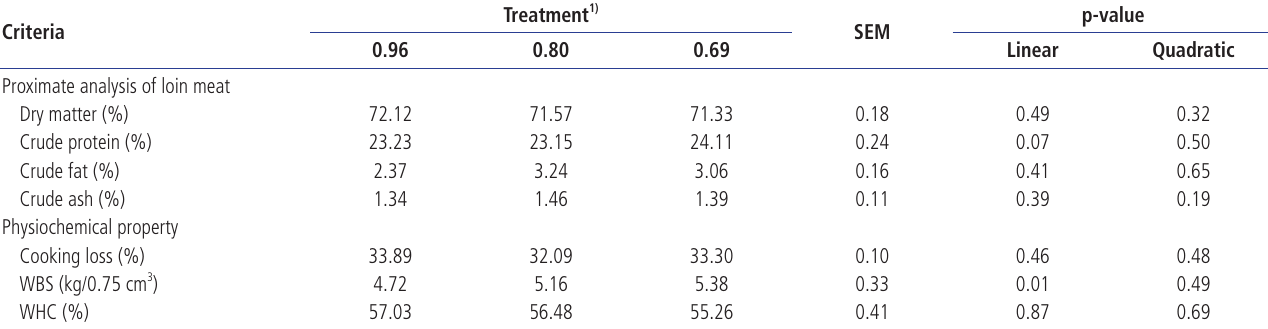
Table 6. Effect of different space allowance on proximate analysis and physiochemical properties of pork Criteria